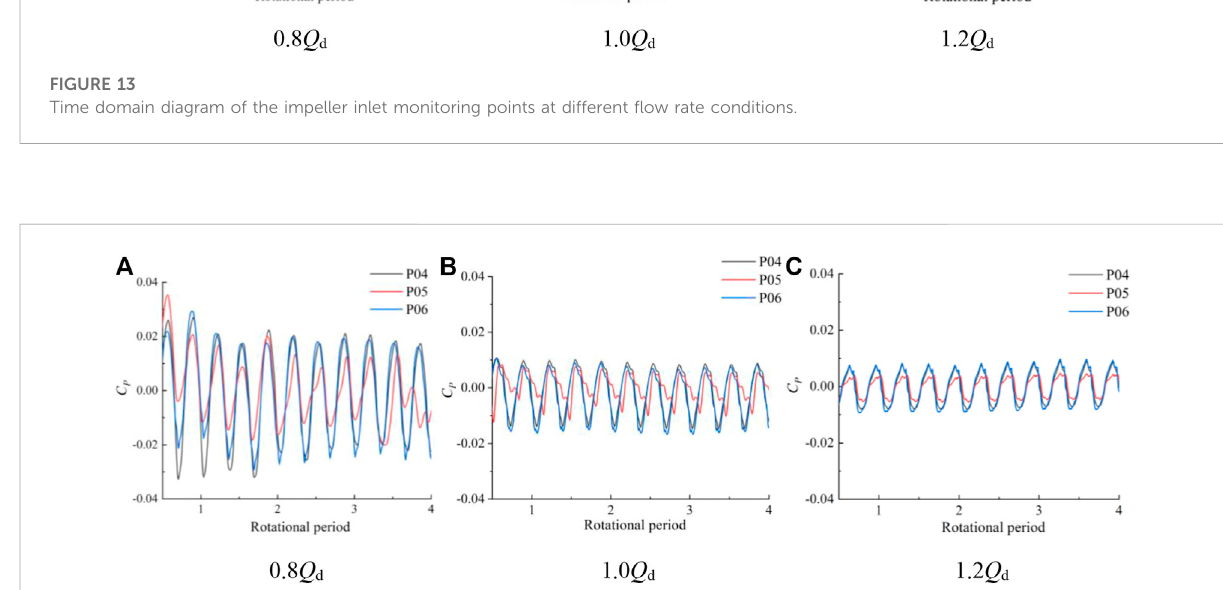
Timedomain diagramofpressurepulsationatthemonitoring pointbetweentheimpeller andguidevanebodyatdifferent fl